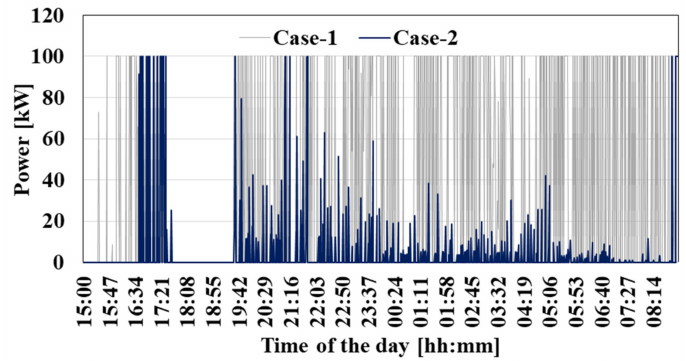
Figure 14. Power consumption of electrolyzer in Case-1 and Case-2.